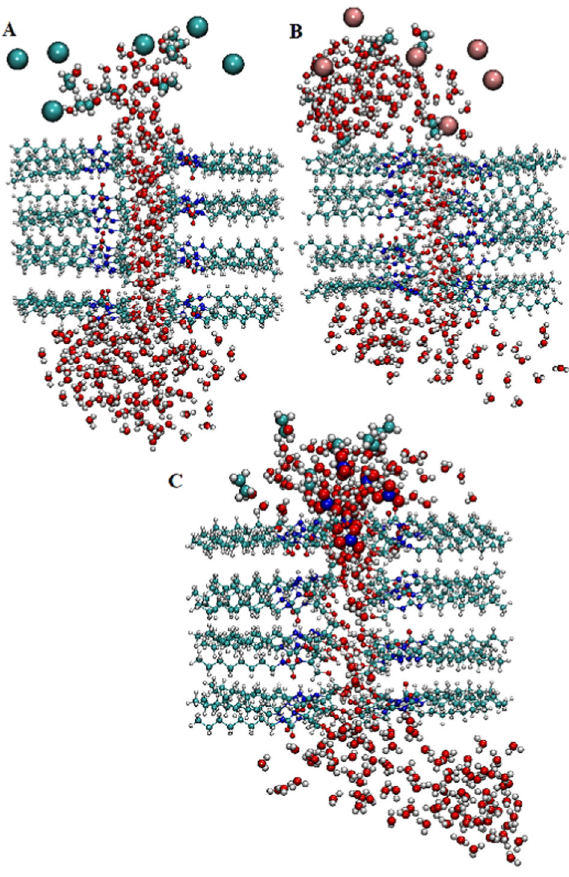
Fig. 3 The fi nal snapshots of the studied systems after 60 ns MD simulation. A ) system C, B ) system B and C ) system A.